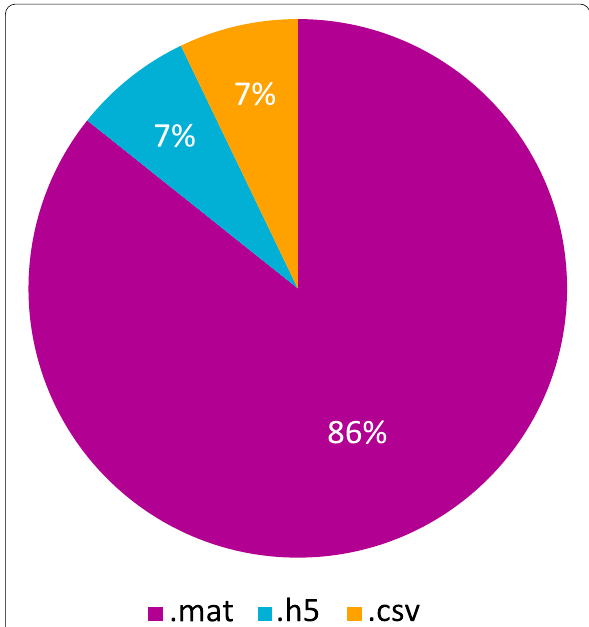
Fig. 1 Distribution of formats of local field potential signals in open datasets, extracted from